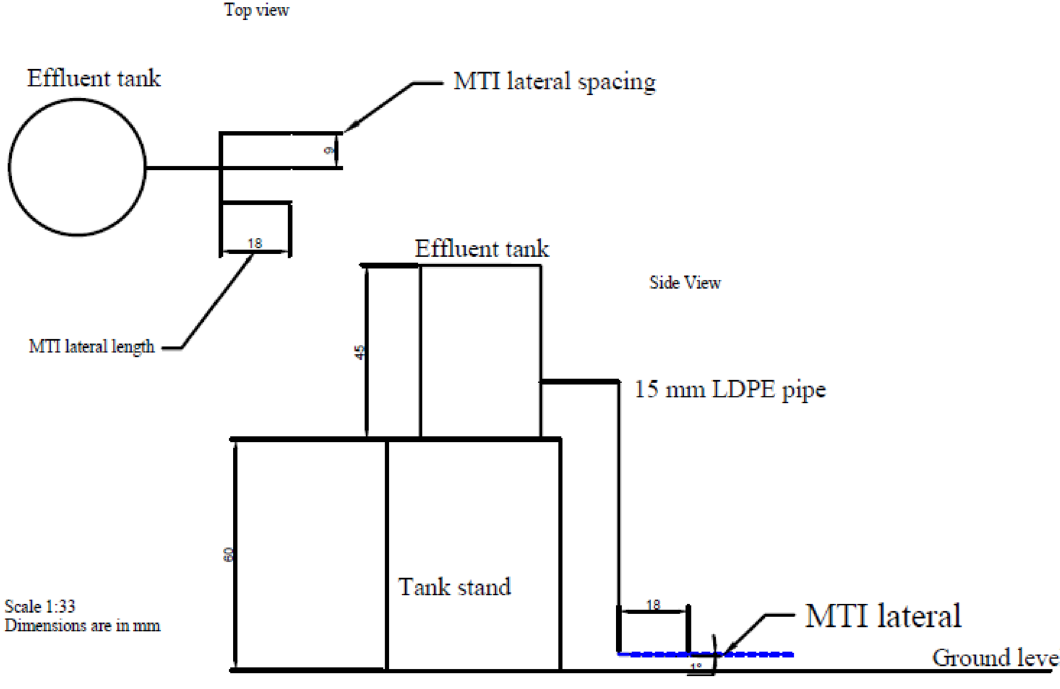
Figure 2. Experimental